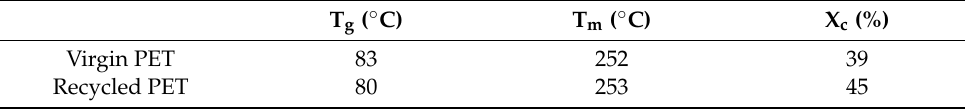
Table 3. T g , T m and X c of virgin and recycled PET.